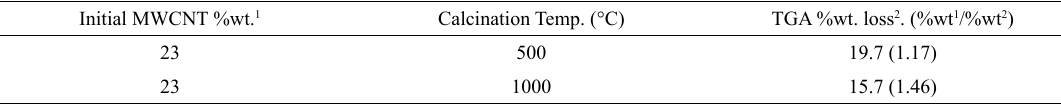
-coated MWCNT composites. Table 2. Carbon content in TiO 2 Initial MWCNT %wt.